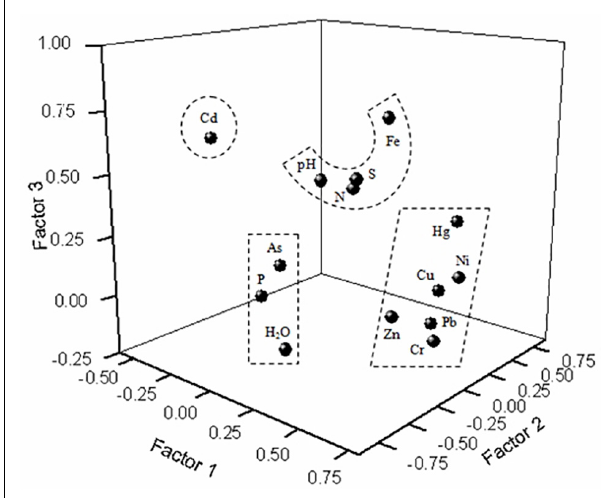
FIGURE 3 | Factor analysis plot